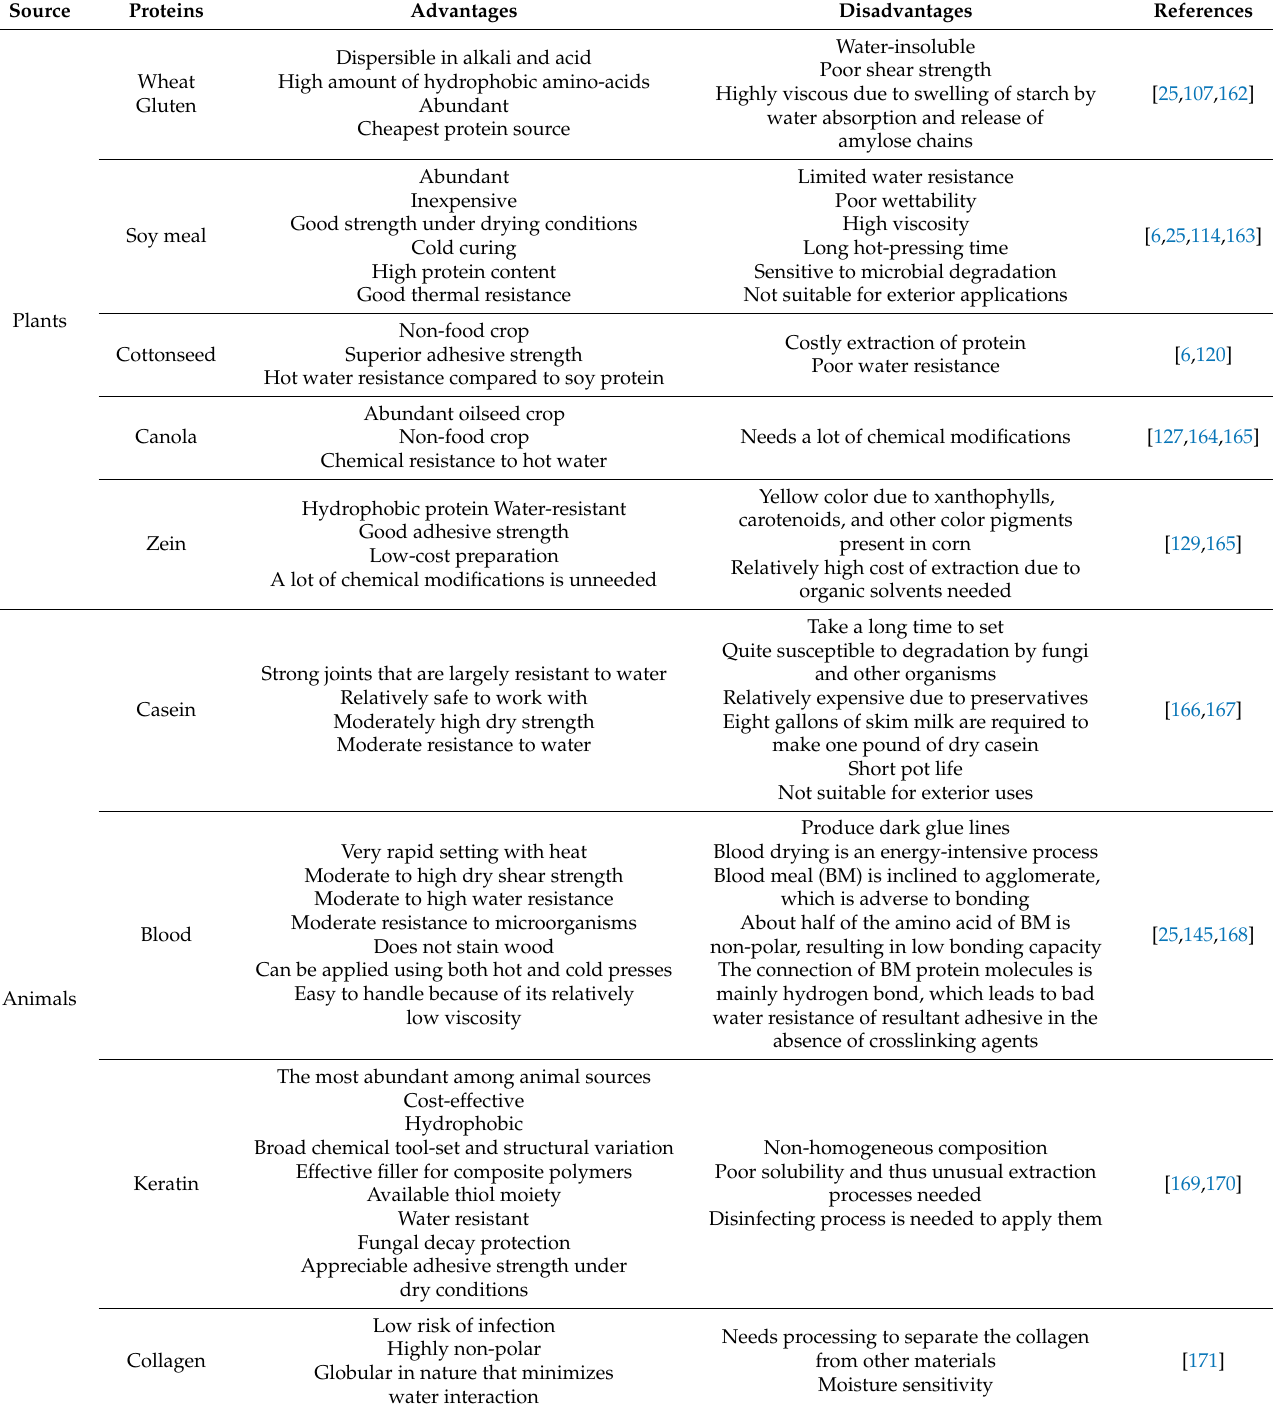
Table 3. Advantages and disadvantages of various protein-based wood